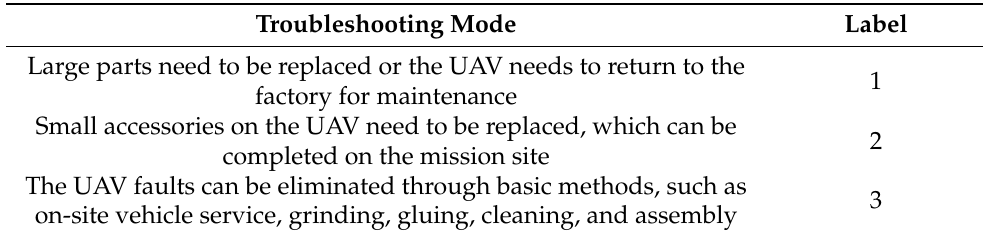
Table 6. Classification of UAV troubleshooting modes and label setting.